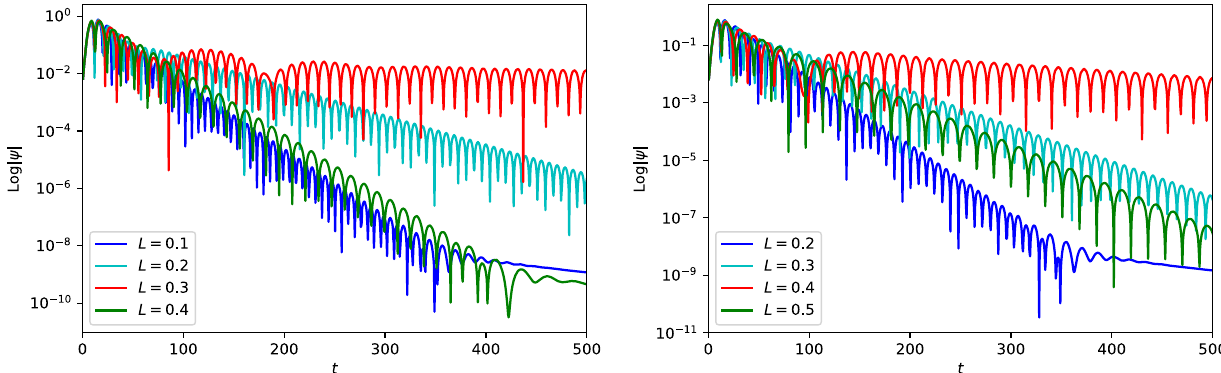
Fig. 12 Semilogarithmic plots for the time-evolution of scalar field perturbation (left panel for l = 0) and electromagnetic field perturbation (right panel for l = 1) to black bounces in a cloud of strings with M = 0 . 5 , L = 0 . 1